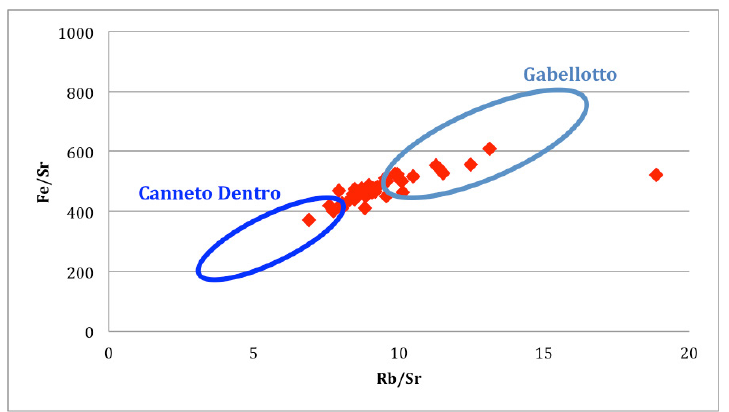
Figure 2c. Plot of Fe/Sr vs Rb/Sr (after Tykot 2017, Fig. 3). The two prehistoric sources Gabellotto and Canetto Dentro appear well separated on the basis of the ratio of these three elements but the Stromboli collection (red diamonds) falls in between and skimms the edges of both rather than falling within one group or the other.